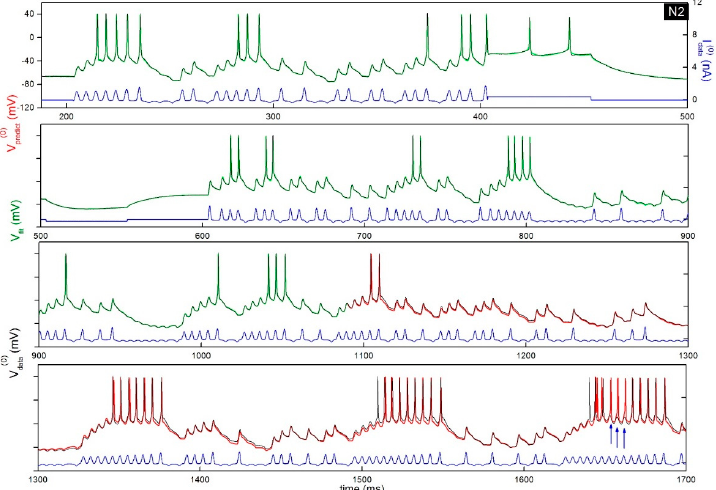
Figure 1. Construction of a model neuron from electrophysiological recordings of interneurons from the songbird brain. The model (green trace) is synchronized to the membrane voltage time series (black trace) of an interneuron of the songbird brain. The model trace is directly overlayed over the data. The neuron membrane voltage was recorded under current stimulation by a protocol (blue trace) mixing chaotic oscillations (Lorenz system) and long current steps. Parameters are ob- tained from the model that best synchronizes its membrane voltage state variable to the data (green trace). This optimal model is then used to forward integrate the current protocol and predict the future state of the neuron (red trace). Here, note that the predicted membrane voltage occasionally departs from the data (black line). The blue arrows show the position of three action potentials miss- ing from the data. These are missing because the current protocol at around 1650 ms is exactly the same as the one giving the continuous bursts at 1350 ms and 1550 ms. The missing action potentials are likely due to input from other neurons in the slide, which cannot be completely eliminated through inhibitors. 2.2. Observability Observability is a measure of how well the state and parameters of a conductance model can be inferred from measurements of the membrane voltage and other experi- mental observations. Takens’ theorem prescribes that all information needed to constrain the model is contained in an observation window of finite duration [52]. Aeyels [53] re- fined this argument by predicting that the number of observations be no less than 2 L + 1, where L is the number of state variables in the system. Electrophysiology and calcium imaging only allow a few state variables to be ob- served, namely the membrane voltage and calcium concentration. Gate variables m i and h i need to be inferred indirectly from time delayed observations of the membrane voltage. Parlitz et al. [54–58] and Letellier et al. [59–61] have studied the properties of the Jacobian matrix, embedding the state vector at time t in the time delayed measurements of the membrane voltage. They show that, when the embedding space is small, this matrix is singular in localized regions of dynamic maps. In those regions, the data do not contain enough information to uniquely constrain the neuron state, and hence, the system is not observable. Increasing the size of the embedding vector to match the number of state var- iables plus parameters was found to eliminate domains where the Jacobian is singular. The length of the assimilation window used to construct neuron models typically has 10,000–100,000 data points for models with less than 100 state variables and parameters